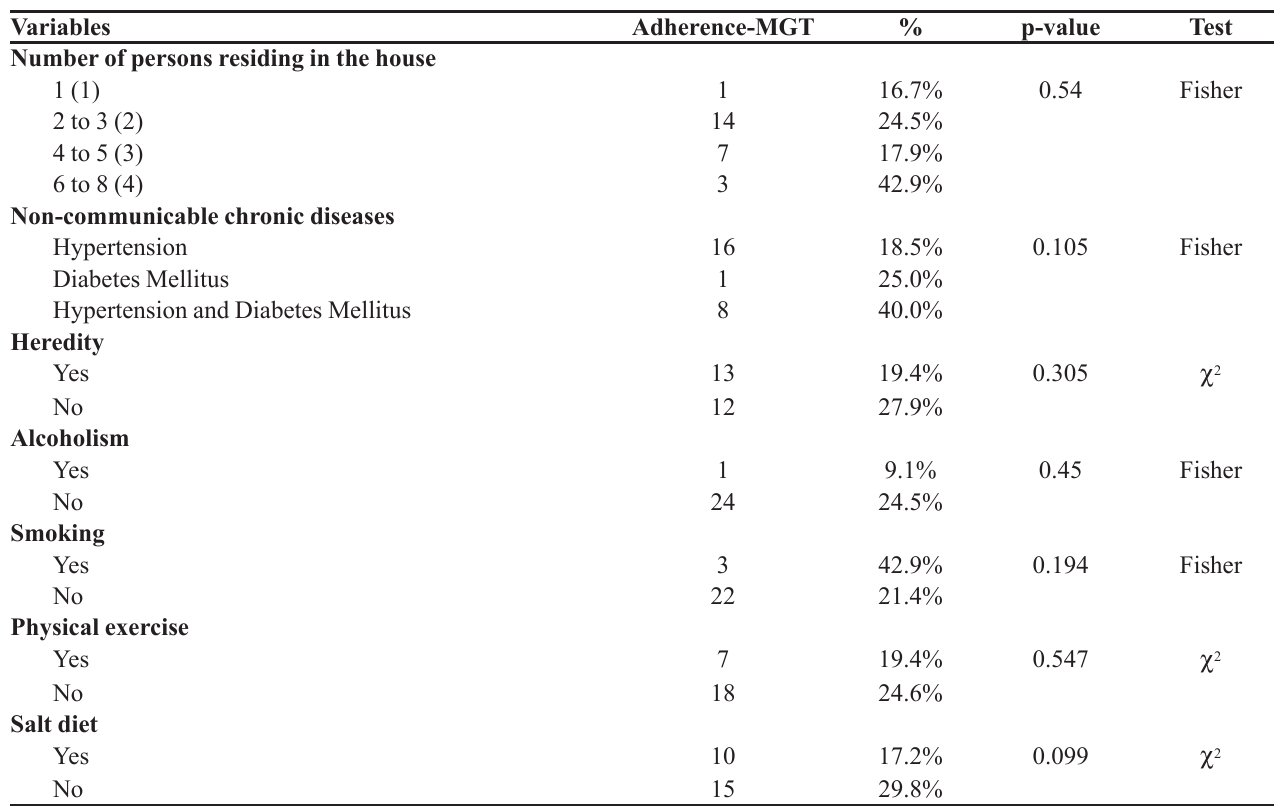
TABLE II - Distribution of sociodemographic and economic variables of Hiperdia users to analyze the association between the variables and adherence to MGT (cont.)